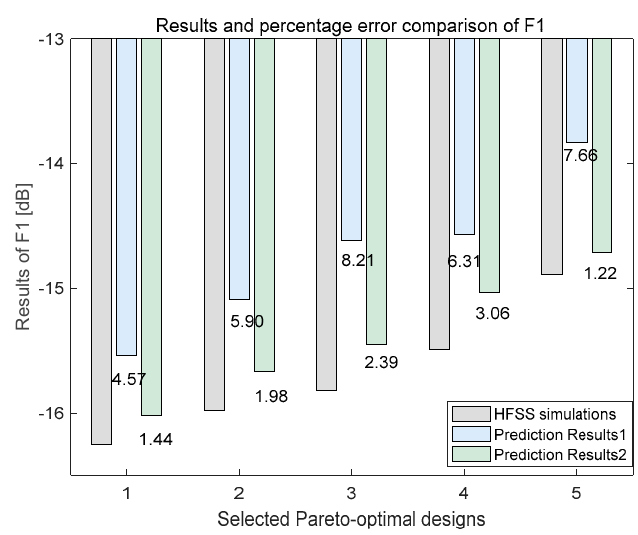
Figure 13. Results and percentage error comparison of fitness F 1 for selected Pareto-optimal designs obtained by High Frequency Structure Simulator (HFSS) and different models. Table 4. Comparison of computational cost among di ff erent antenna optimization